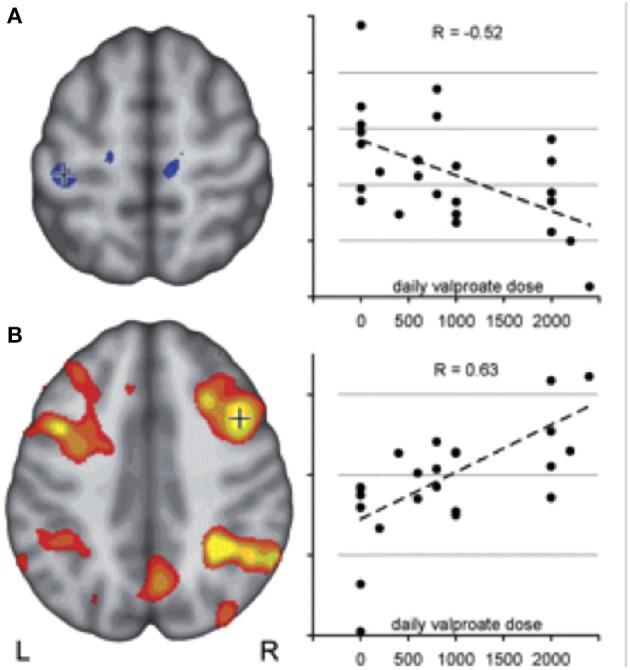
Motor cortex coactivation correlates with valproic acid dosage in JME duting working memory task fMRI. Co-activation of motor and cognitive areas during a visuo-spatial working memory task was detected in JME compared with controls. The figure illustrates: (A) a negative correlation between left central activation (voxels underneath crosshair) and daily valproate dose indicating a normalizing effect of VPA on motor cortex hyperactivity. (B) Activity within the typical bilateral frontal and parietal working memory network, on the other hand, correlated positively with valproate dose, indicating a normalizing effect of valproate on the cortical activation pattern in JME. Reproduced with permission from Vollmar et al. (17).